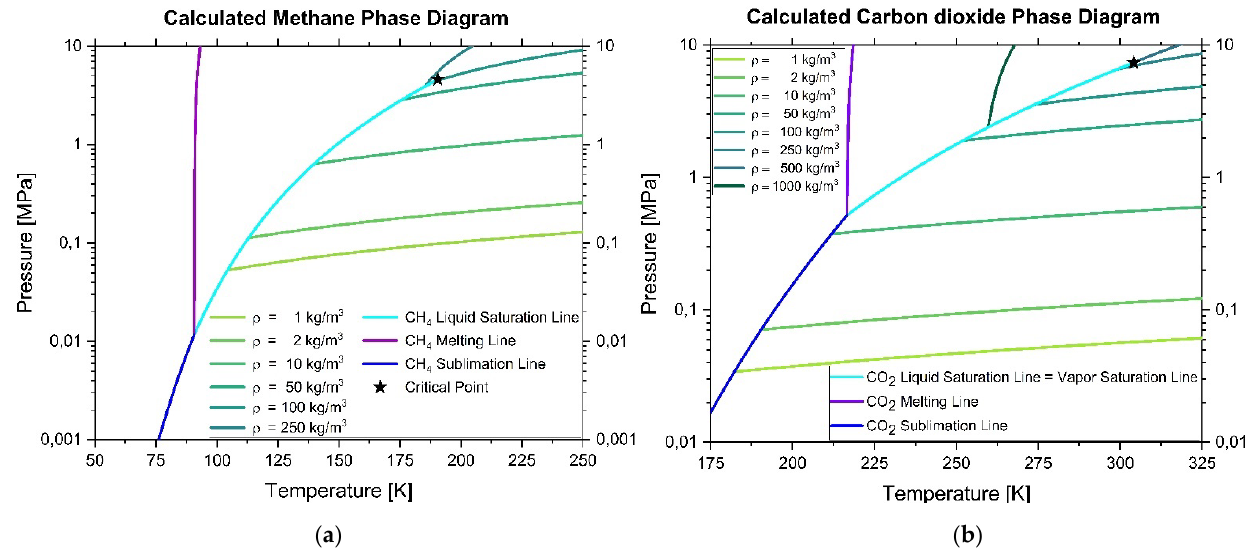
Figure 1. ( a ) Calculated phase diagram of pure methane for pressures between 1 kPa and 10 MPa and temperatures between 50 and 250 K. (Linear temperature scale; logarithmic pressure scale. Vapor saturation line = liquid saturation line: cyan blue color; melting line: violet color; sublimation line: dark blue color, black star: critical point, densities: other green colored lines). ( b ) Calculated phase diagram of pure carbon dioxide for pressures between 10 kPa and 10 MPa and temperatures between 175 and 325 K. (Linear temperature scale; logarithmic pressure scale. Vapor saturation line = liquid saturation line: cyan blue color; melting line: violet color; sublimation line: dark blue color, black star: critical point, densities: other green colored lines). Table 2. Characteristic points of the phase diagrams of methane [5,6] and carbon dioxide [5,9].